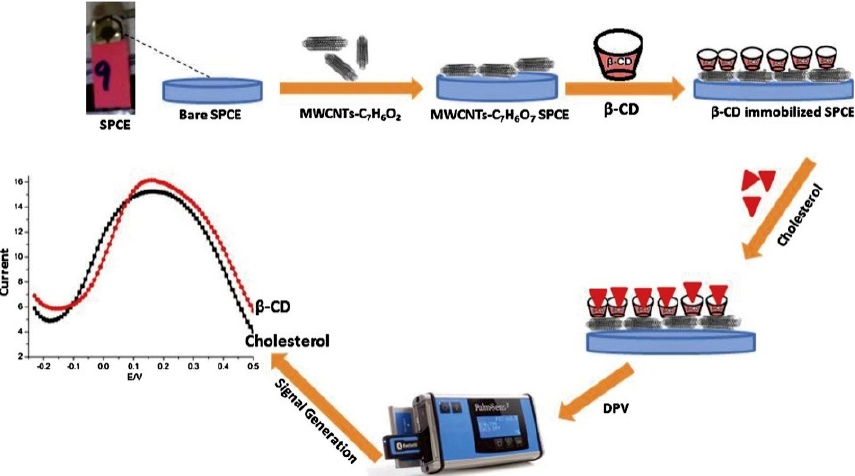
Figure 15. Schematic illustration of the preparation of SPCE/MWCNTs/ β -cyclodextrin sensor for the measurement of cholesterol. Reprinted with permission from Ref. [83].